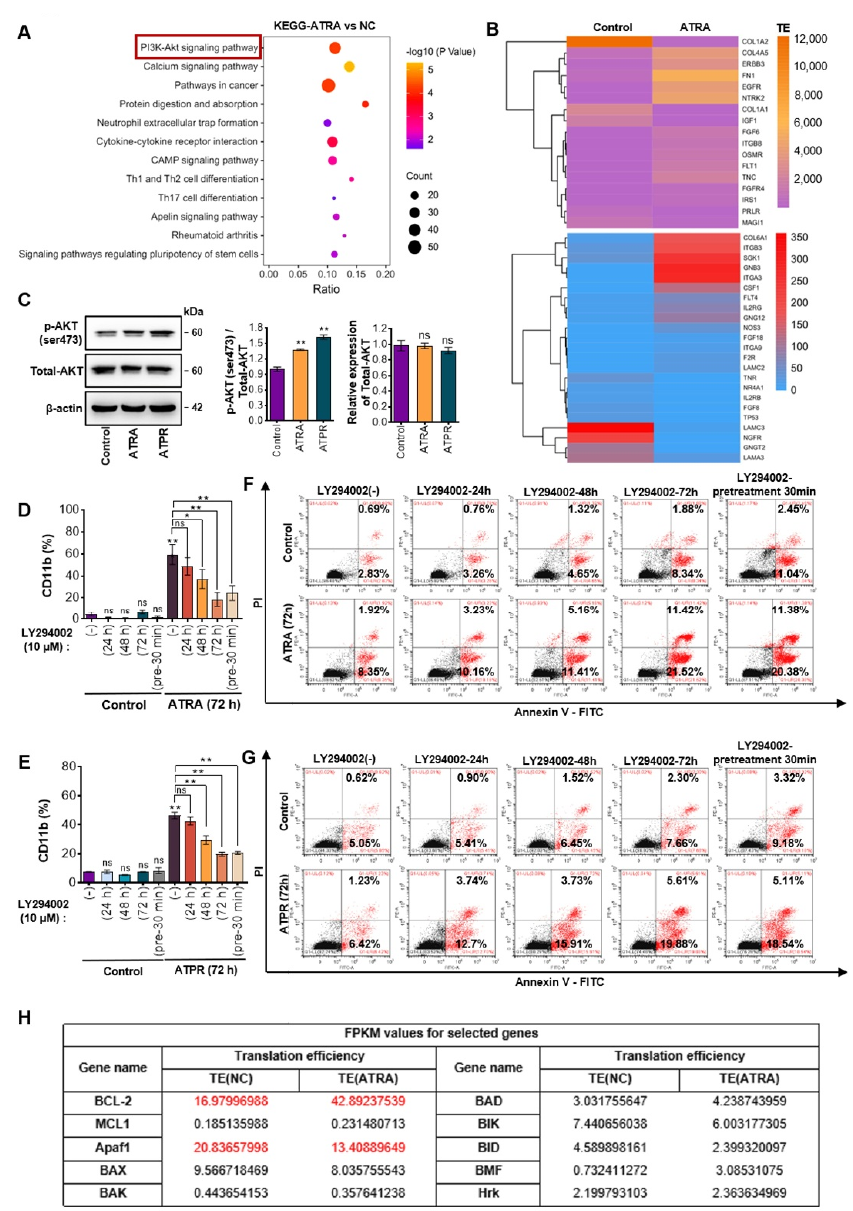
Figure 5. PI3K/AKT signaling was activated by ATRA and ATPR. ( A ) KEGG enrichment analysis of TE ‐ sensitive genes (including TE down ‐ regulated genes and TE up ‐ regulated genes) during ATRA stress. ( B ) Heatmap of TE value for TE ‐ sensitive genes enriched in the PI3K/AKT pathway. ( C ) PI3K/AKT activity was evaluated by detecting the protein expression of AKT and the phosphorylation level of AKT at ser473 using western blot. ( D and E ) Molm13 cells were simultaneously treated with ATRA (10 μ M, D ) or ATPR (10 μ M, E ) and LY294002 (10 μ M), a PI3K/AKT inhibitor, for the indicated times. Cell differentiation was analyzed by quantifying the proportion of CD11b ‐ positive cells by flow cytometry. ( F and G ) Apoptosis of cells treated with ATRA ( F ) or ATPR ( G ) and LY294002 was assessed by flow cytometry using an Annexin V ‐ FITC/PI staining kit. In the “LY294002 ‐ pretreatment 30 min” panel, cells were pre ‐ treated with PI3K/AKT inhibitor (LY294002) for 30 minutes, and then ATRA or ATPR were directly added to the medium containing LY294002. ( H ) Fragments per kilobase of exon per million fragments (FPKM) values of apoptotic genes translationally regulated by ATRA. ns, not significant; * p < 0.05, ** p < 0.01.